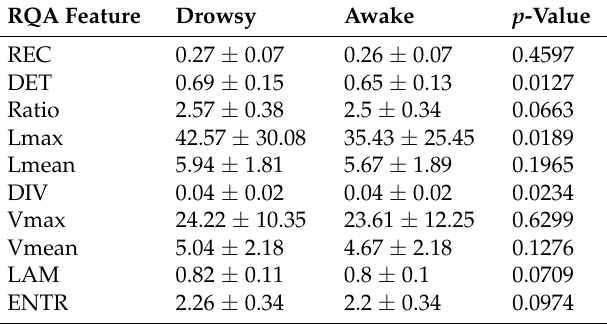
Statistical significance of RQA features for awake/drowsy differentiation from photoplethysmogram (PPG)